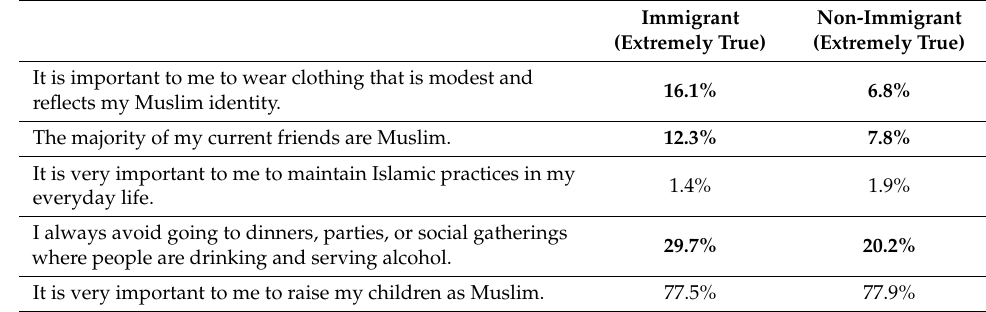
Table 3. Immigrant and Non-Immigrant Item Differences in Islamic Values.